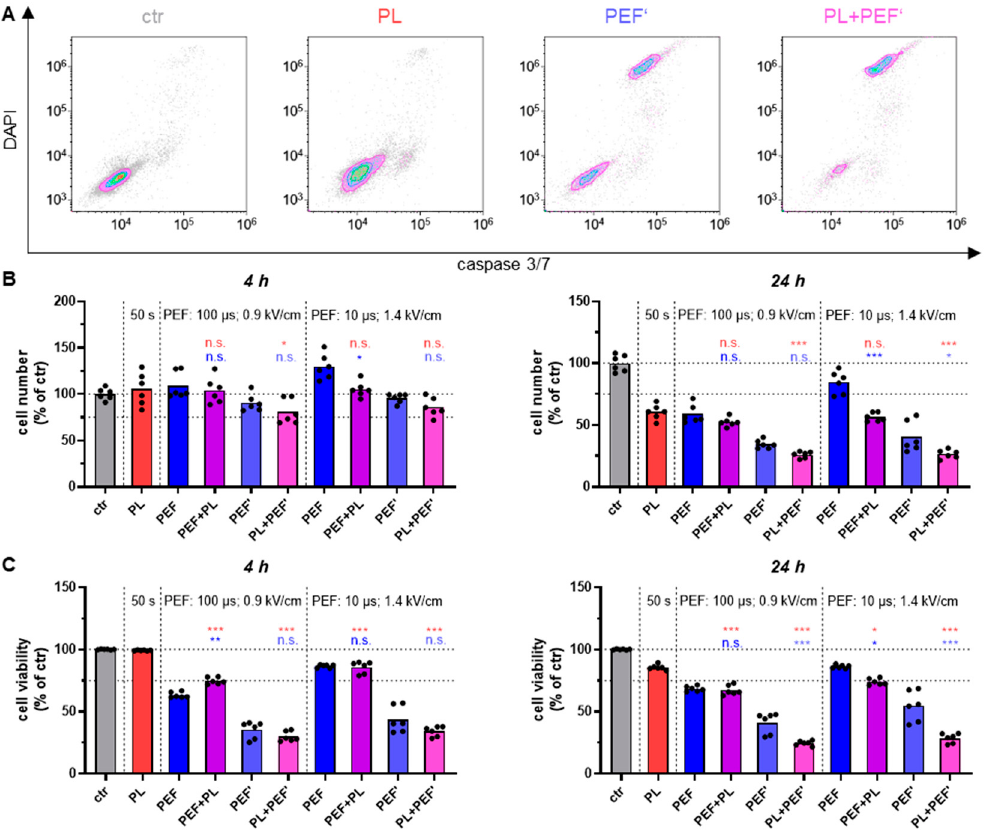
Figure 2. Combination effect of different plasma and PEF treatments on Jurkat cells in DMEM regarding cell viability and number. The cell viability was measured by DAPI and CellEvent Caspase- 3/7 Green Detection Reagent using flow cytometry after 4 h and 24 h ( A , C ). Concurrently, the cell number was determined ( B ). Data are shown as one representative ( A ) or mean from three independent experiments with several replicates each ( B , C ). One-way ANOVA with Turkey’s multiple comparison test was performed (*: p < 0.05, ** p < 0.01 and ***: p < 0.001). ctr: control; PL: plasma; PEF: pulsed electric field; PEF’: cells were seeded into 96-well plates before being transferred into cuvettes; n.s.: not